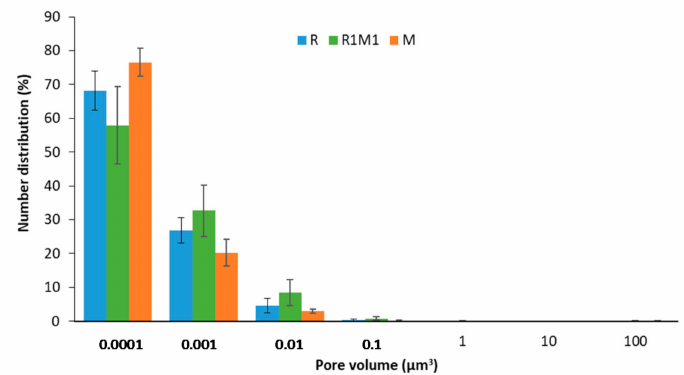
Figure 5. Pore size distribution in single-layer printed samples after